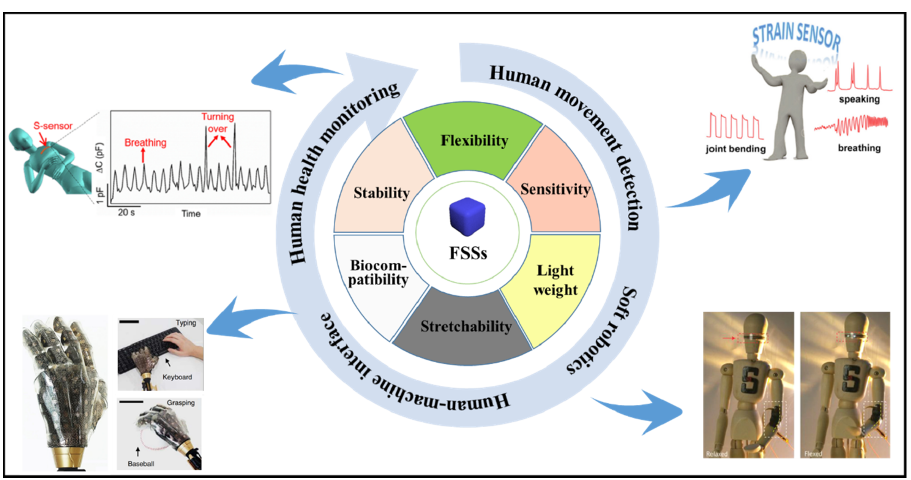
Figure 1. Summary of the properties and applications of flexible strain sensors [6–9].